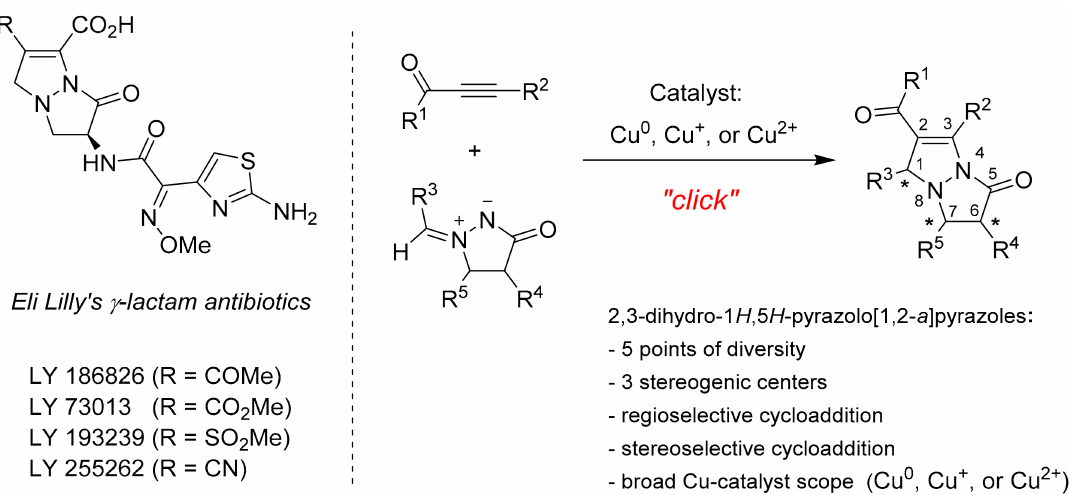
Figure 1. Examples of bioactive bicyclic pyrazolidinones ( left ) and CuAIAC reaction ( right